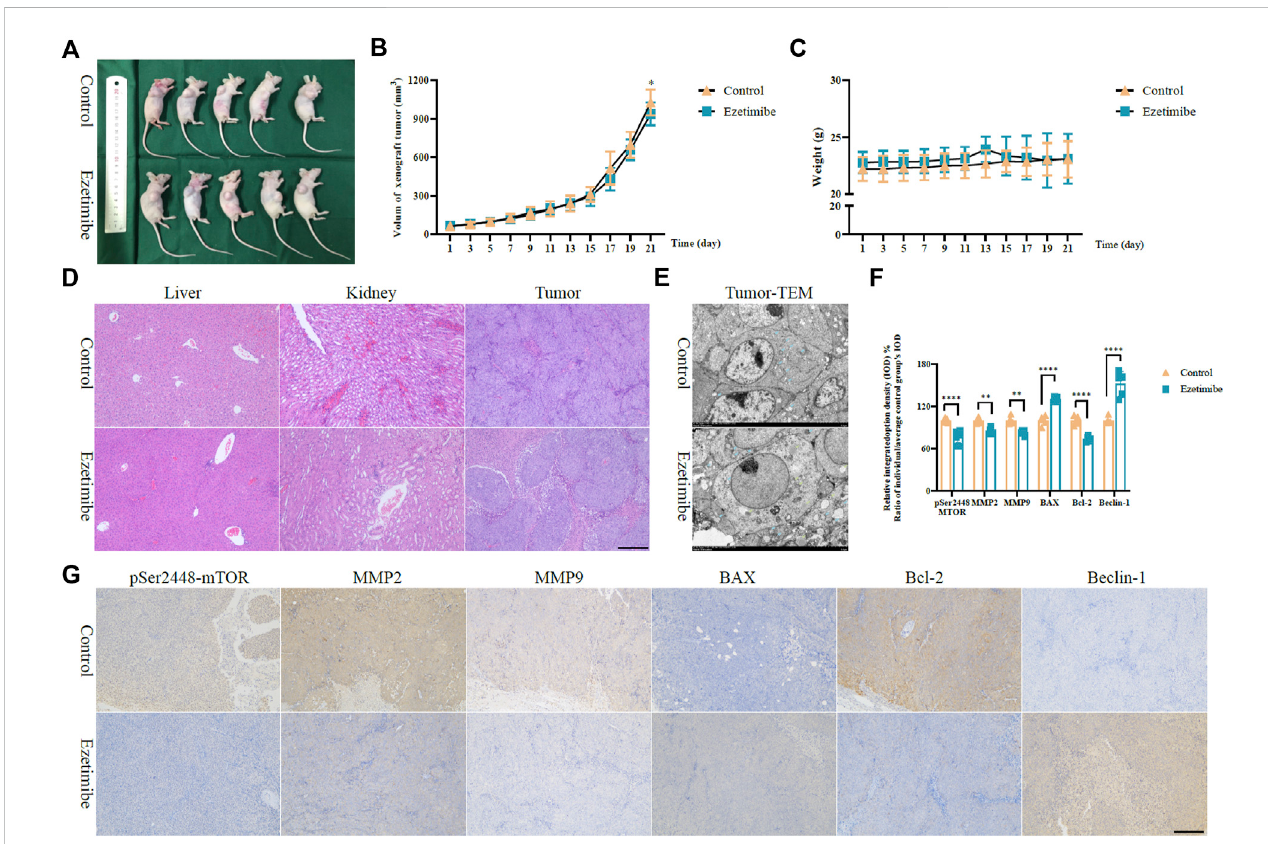
FIGURE 6 Ezetimibe functions an anti-colorectal cancer role in xenograft mice model. (A) Subcutaneous HCT116 xenograft mice model of control and ezetimibe treated groups. (B) The volum of subcutaneous tumor ingroups of control and ezetimibe. (C) The mouse weights of control and ezetimibe treated group. (D) H&E staining measurement for liver and kidney in groups of control and ezetimibe. (E) Transmission electron microscopic observations for groups of control and ezetimibe. (F) Statistical analysis for the immunohistochemistry of mTOR pSer1448 , MMP-2, MMP-9, BAX, Bcl-2, Beclin-1 in groups of control and ezetimibe. (G) ImmunohistochemicalstainingformTOR pSer1448 ,MMP-2,MMP-9,BAX,Bcl-2,Beclin-1ingroupsofcontrolandezetimibe.* p < 0.05,** p < 0.01, **** p <